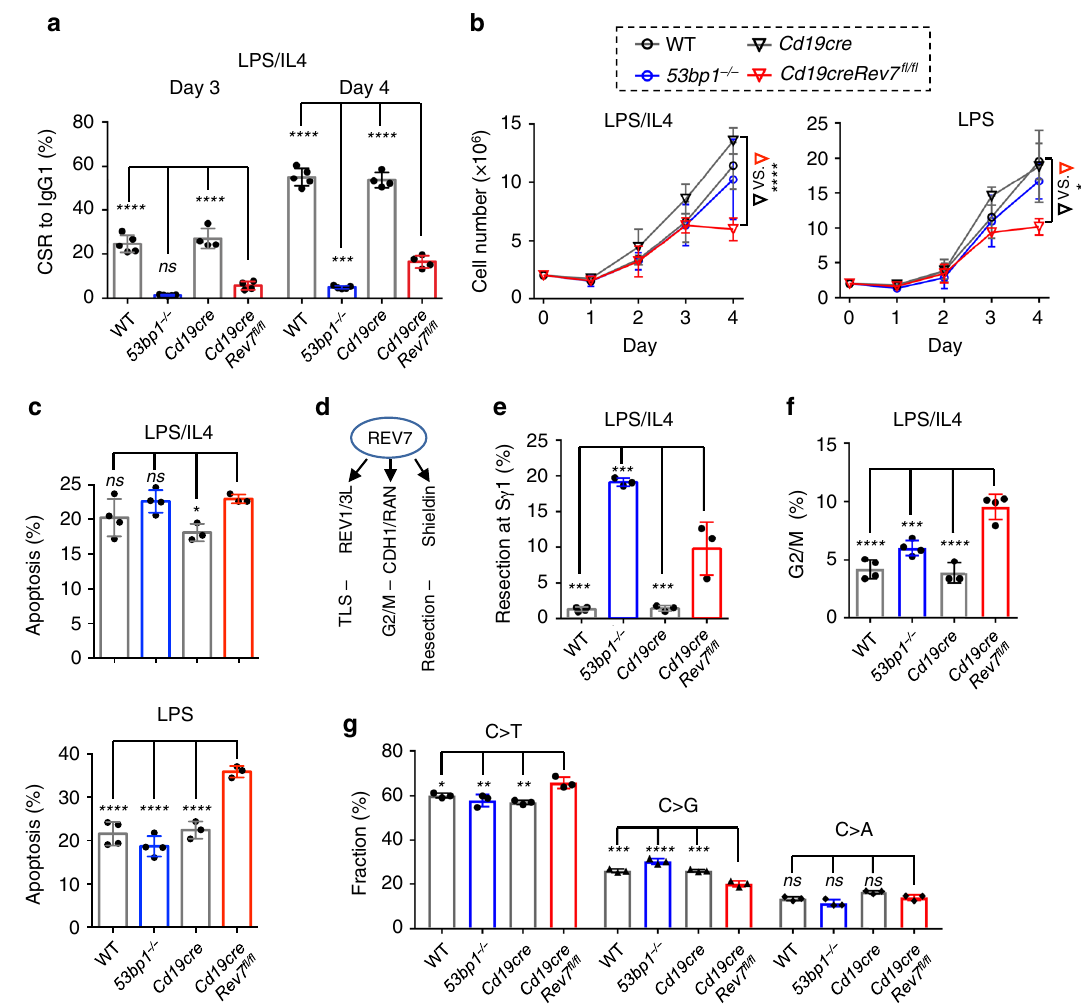
Fig. 1 REV7 is required for B-cell viability during CSR. a CSR levels to IgG1 after LPS/IL4 stimulation at Day 3 and 4. n = 5 for WT and 53bp1 − / − ; n = 4 for Cd19cre and Cd19cre Rev7 fl / fl . b Growth curve of indicated B cells upon LPS/IL4 (left) or LPS (right) stimulation. Cell numbers at Day 4 of four sets of mice are subjected to statistical calculation. n = 4 for all genotypes. c Percentages of apoptotic cell (AnnexinV + PI − ) at Day 4 after stimulating with LPS/IL4 (upper) or LPS (lower) are plotted. n = 4 for WT and 53bp1 − / − ; n = 3 for Cd19cre and Cd19cre Rev7 fl / fl . d Multiple roles of REV7. e End resection of AID- initiated breaks at S γ 1 is shown for indicated B cells. Resection ratio is de fi ned as previously reported 37 . n = 4 for WT; n = 3 for 53bp1 − / − , Cd19cre , and Cd19cre Rev7 fl / fl . f Percentage of cells in G2/M phase is plotted for the indicated genotypes. n = 4 for WT, 53bp1 − / − , and Cd19cre Rev7 fl / fl ; n = 3 for Cd19cre . g Mutation spectrum of C/G in the 5 ′ S μ region is shown for both strands of genomic DNA. n = 3 for all genotypes. n , independent mice. Data are represented as mean ± SD in a , b , c , e , f , and g . Two-tailed unpaired t -test was performed for b and one-way ANOVA followed by Dunnett ’ s multiple comparisons test was performed for a , c , e , f , and g . Data from Rev7 knockout are compared with those from other genotypes. **** p < 0.0001, *** p < 0.001, ** p < 0.01, * p < 0.05, ns: p > 0.05. P -values and sample sizes are provided in Supplementary Table 2. Source data are provided as a Source Data fi S region DNA ends at a less severe level compared with that in 53BP1 de fi ciency (Fig. 1e and Supplementary Fig. 2b, c),